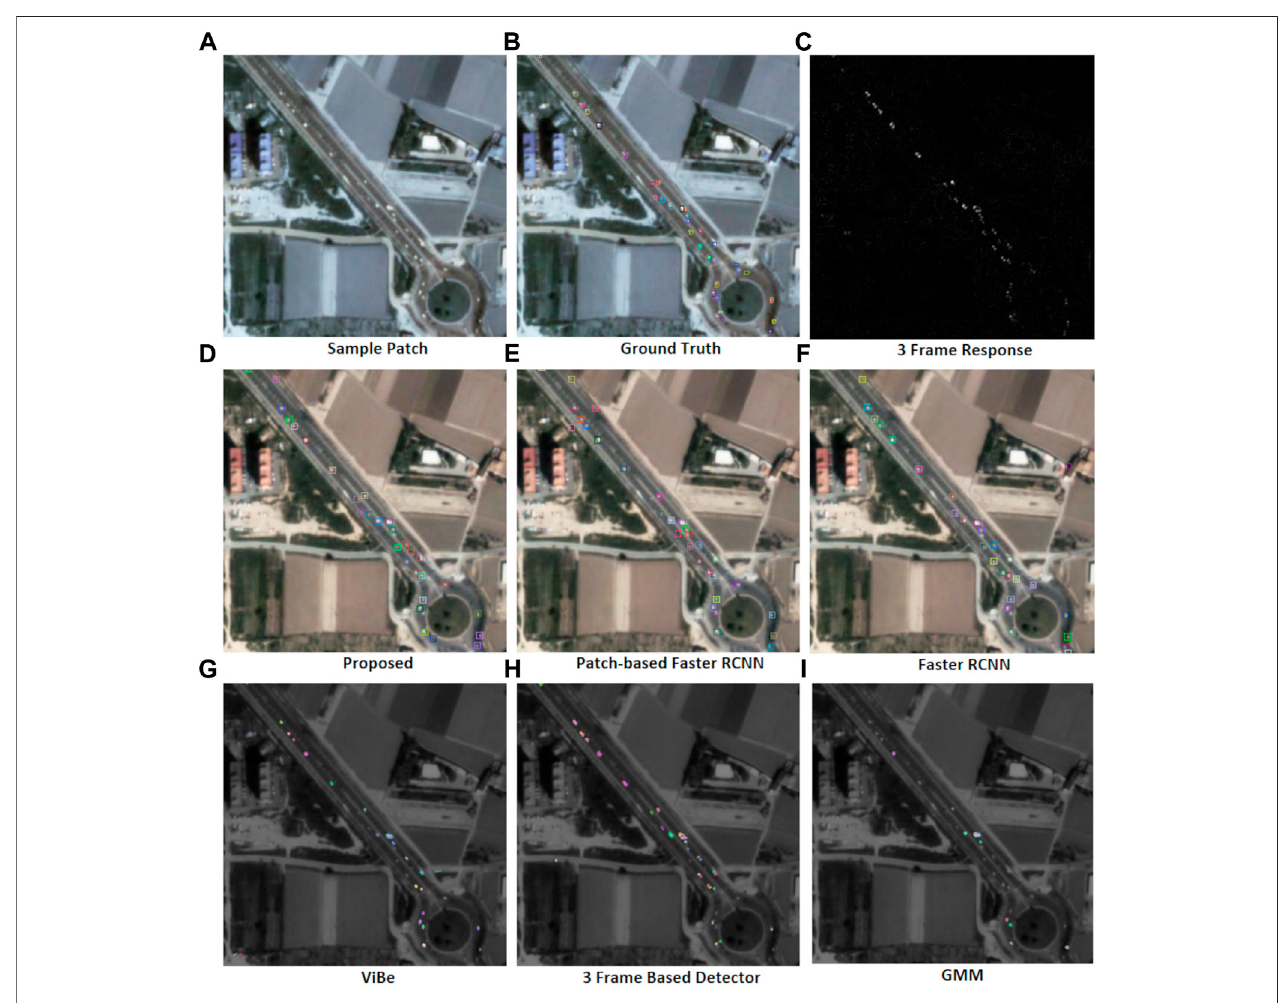
FIGURE 6 | Sample object detection in sub-region of AoI 1. First row: (A) sample patch . (B) Ground truth bounding boxes. (C) 3-frame difference response. Secondrow: (D) Proposed method. (E) Output ofpatched-based FasterRCNN. (F) Output ofFasterRCNN.Thirdrow: (G) Output ofViBe. (H) Output of3framebased detector. (I) Output of GMM